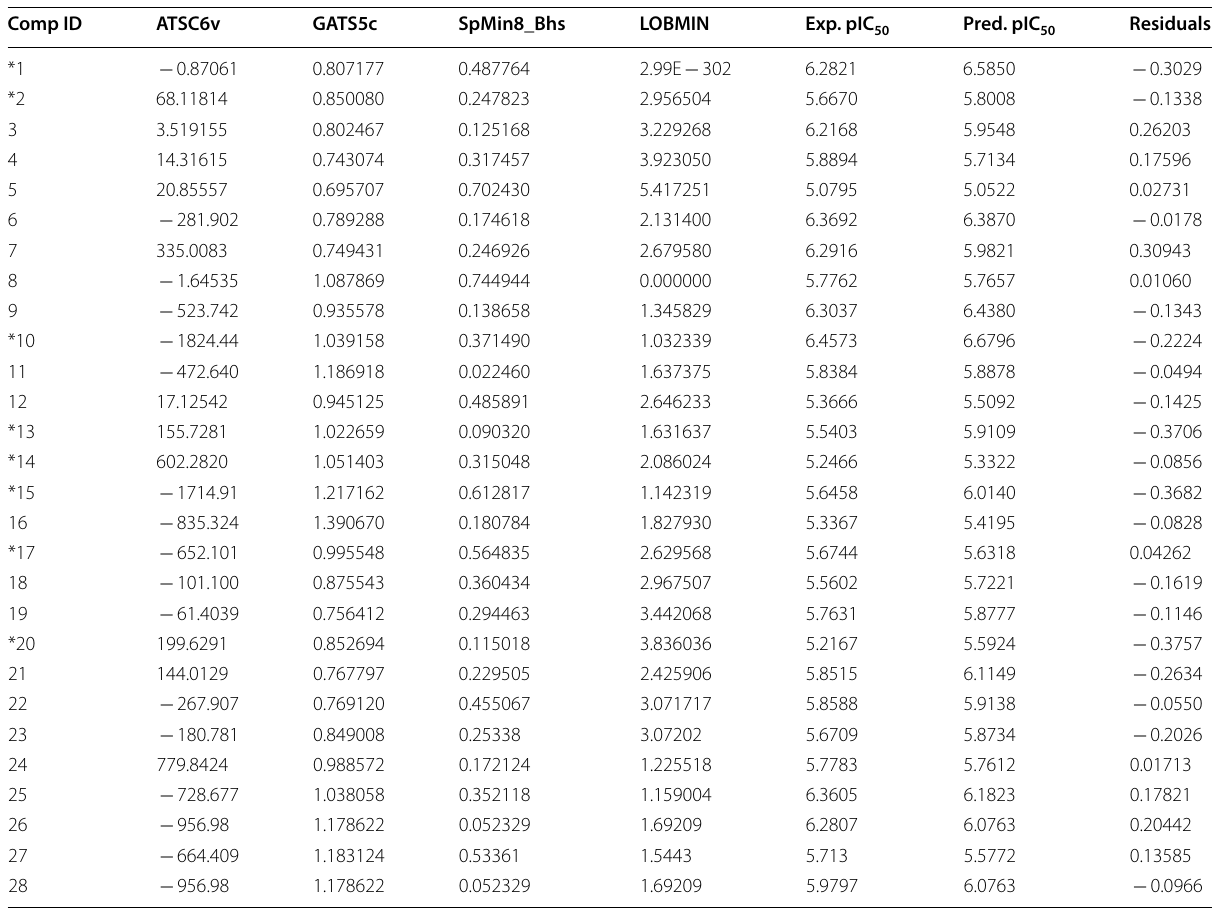
, predicted pIC and residuals of the maleimides 50 50